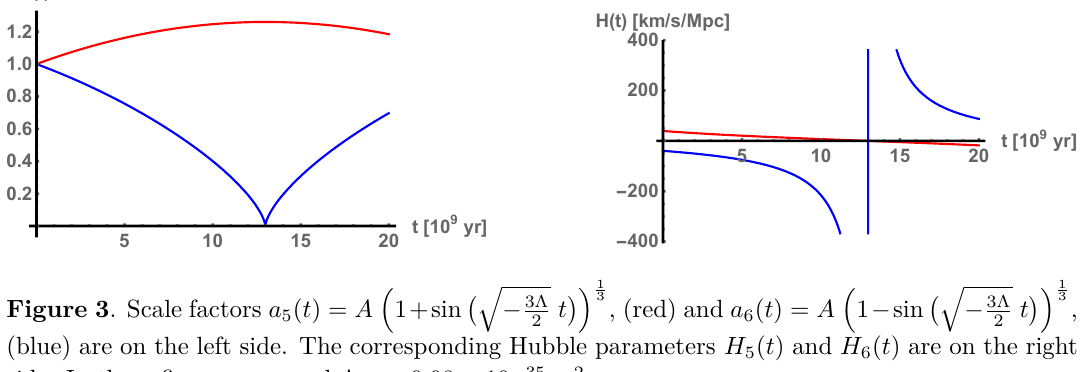
Figure 3 . Scale factors a 5 ( t ) = A (blue) are on the left side. The corresponding Hubble parameters H side. In these figures, we used Λ = − 0 . 98 × 10 − 35 s − 2